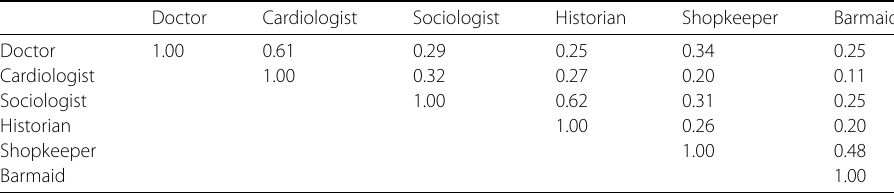
Table 1 Semantic closeness of selected occupations (cosine similarity, CC